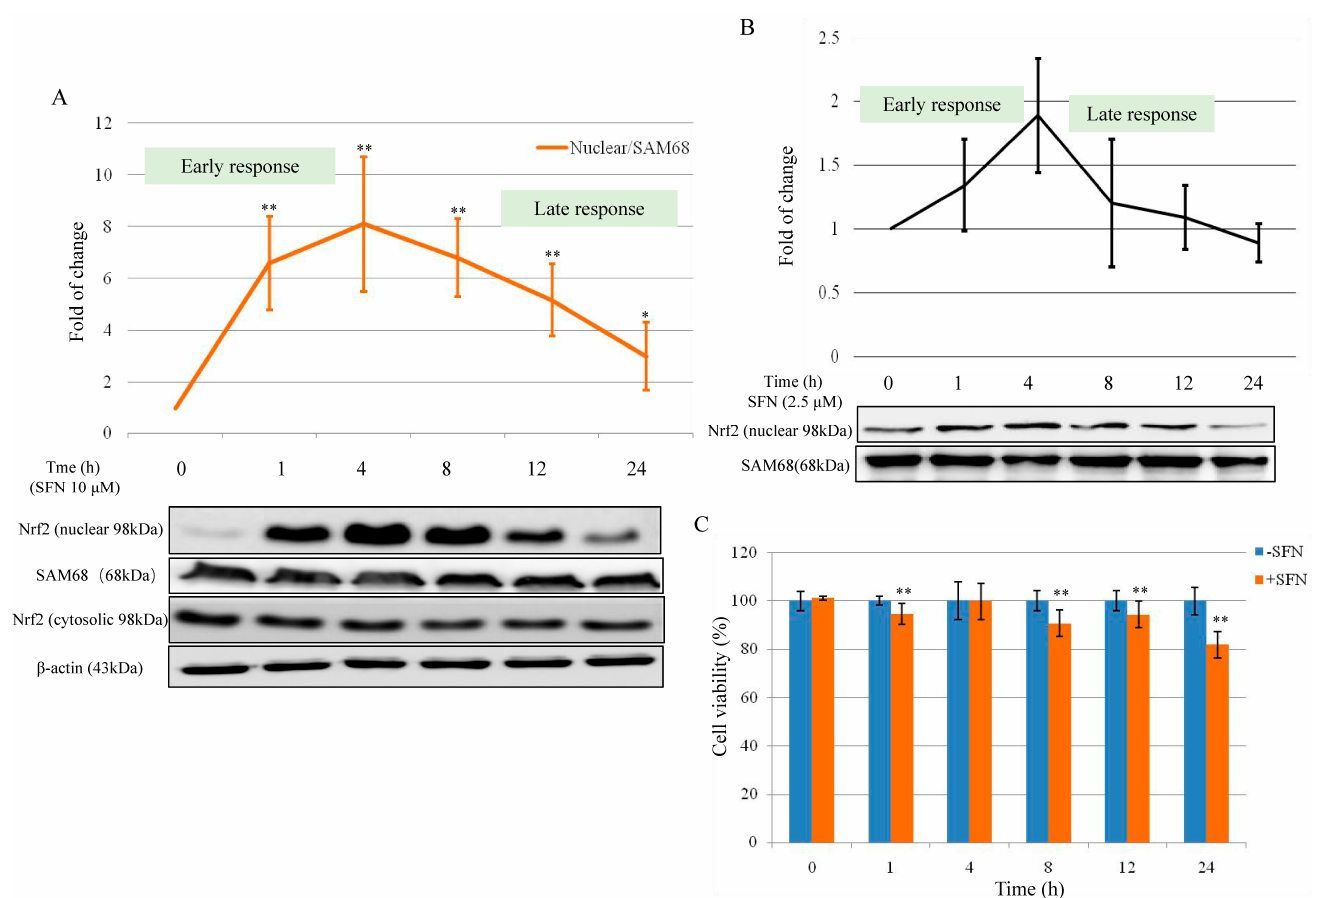
Figure 2. Effect of SFN on Nrf2 expression and cell viability. ( A ) Effect of SFN (10 µM) on Nrf2 nuclear and cytosolic expression after treatment from 0 to 24 h. SAM68 was used as loading control for the nuclear fraction, β -Actin was used as loading control for the cytosolic fraction. ( B ) Nrf2 nuclear expression after SFN 2.5 µM treatment from 0 to 24 h. SAM68 was used as a loading control for the nuclear fraction. ( C ) T24 cell viability was tested after treatment with 10 µM SFN from 0 to 24 h. All data represent the mean ± SD of three experiments in which each treatment was performed in six replicates. Statistical significance versus control: * P < 0.05, ** P < 0.01.